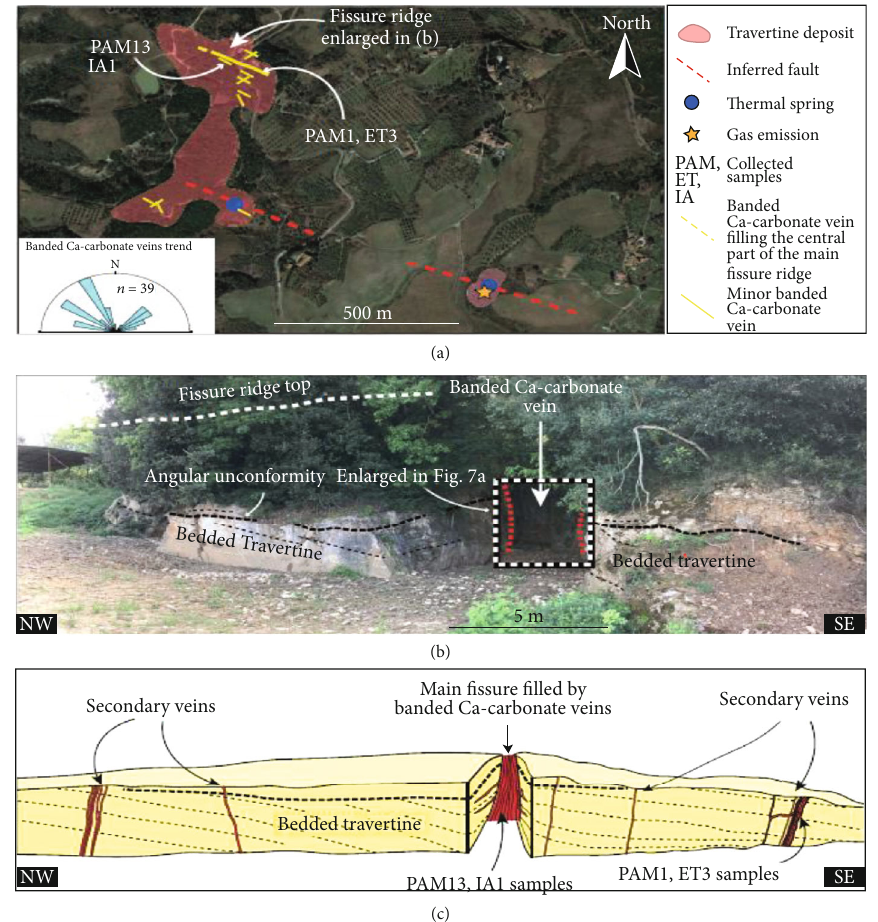
Figure 6: (a) Aerial photograph indicating the travertine deposit, the location of fi ssure ridge and gas emission, and collected samples; the orientation of the banded Ca-carbonate veins is also indicated in the rose diagram, (b) Fissure ridge made up of a central fracture completely fi lled by banded Ca-carbonate veins, showing the locations of samples PAM13 and IA1. (c) Schematic reconstruction of the travertine fi ssure ridge with the location of the collected